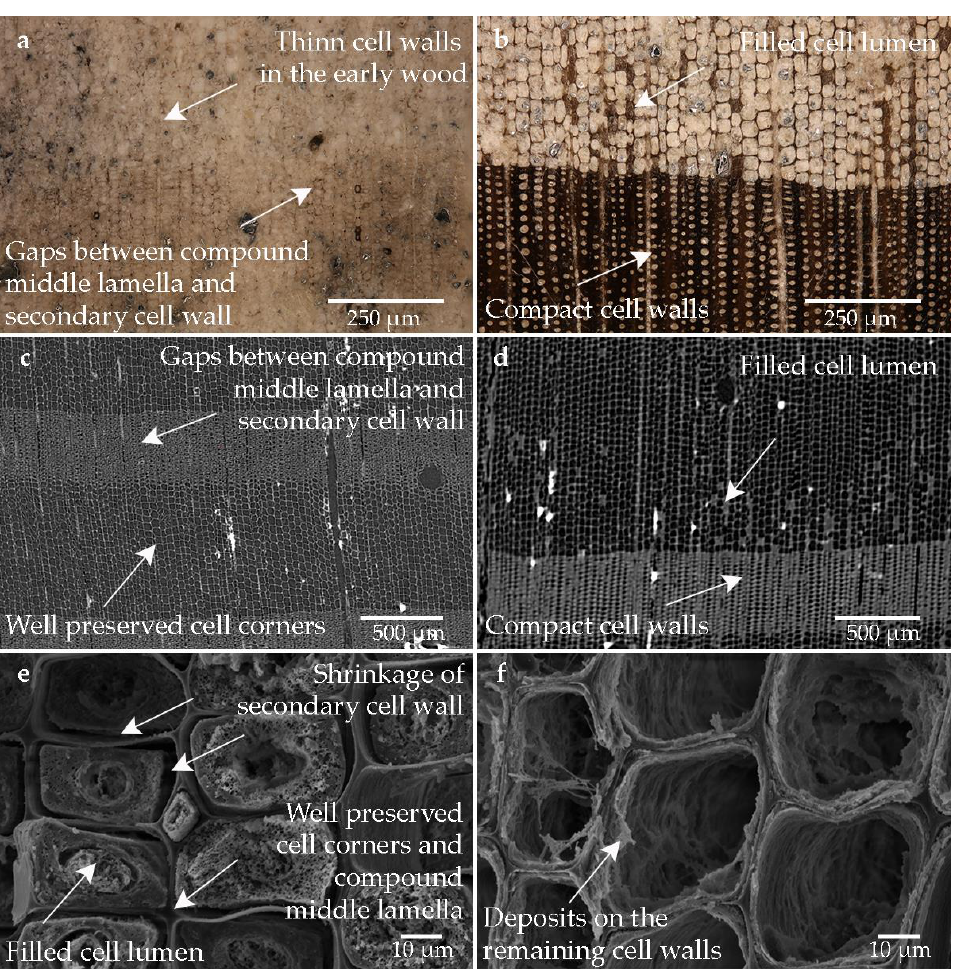
Figure 3. Microscopic wood structure of sample conserved with alcohol-ether-resin (Pi1-AlEt) ( a ) RLM image from the high degraded area; ( b ) RLM image from the low degraded area; ( c ) CT image of the cross section of the heavily degraded sample ( d ) CT image of the cross section of the low degraded sample ( e ) SEM image of the latewood tracheids; ( f ) SEM image of the earlywood tracheids in the heavily degraded area.